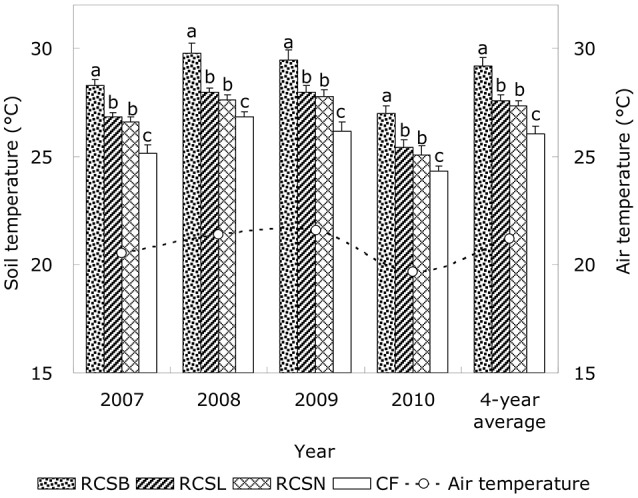
Average soil temperature in the 5 cm soil layer during the early growth period (30 days after sowing) of corn from 2007 to 2010. RCSB means rain-harvesting ridges and furrows planting covered with 8% biodegradable films in furrows; RCSL means rain-harvesting ridges and furrows planting covered with liquid films in furrows; RCSN means rain-harvesting ridges and furrows planting with no films mulching in furrows; CF means the conventional flat planting without film mulching. Lowercase letters indicate significant differences among treatments (LSD test, P < 0.05). Bars represent standard deviations.